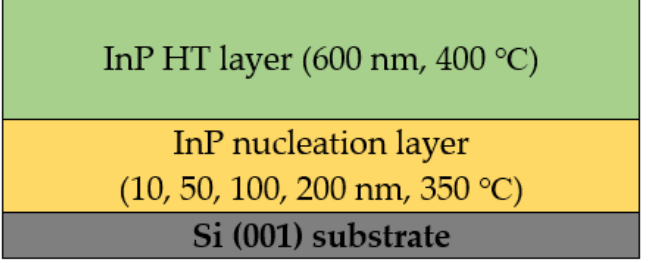
Figure 1. Schematic of InP epitaxial structures on Si(001) substrate.